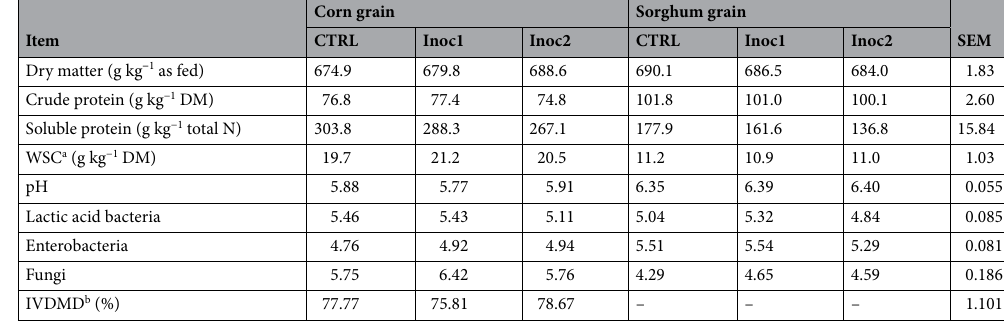
Table 1. Average chemical composition, pH and microbial populations (log cfu/g of fresh weight) of rehydrated corn and sorghum grains before fermentation. CTRL non-inoculated, Inoc1 Lactobacillus plantarum and Propionibacterium acidipropionici , Inoc2 Lactobacillus buchneri. a Water soluble carbohydrate. b In vitro dry matter digestibility. c Standard error of the